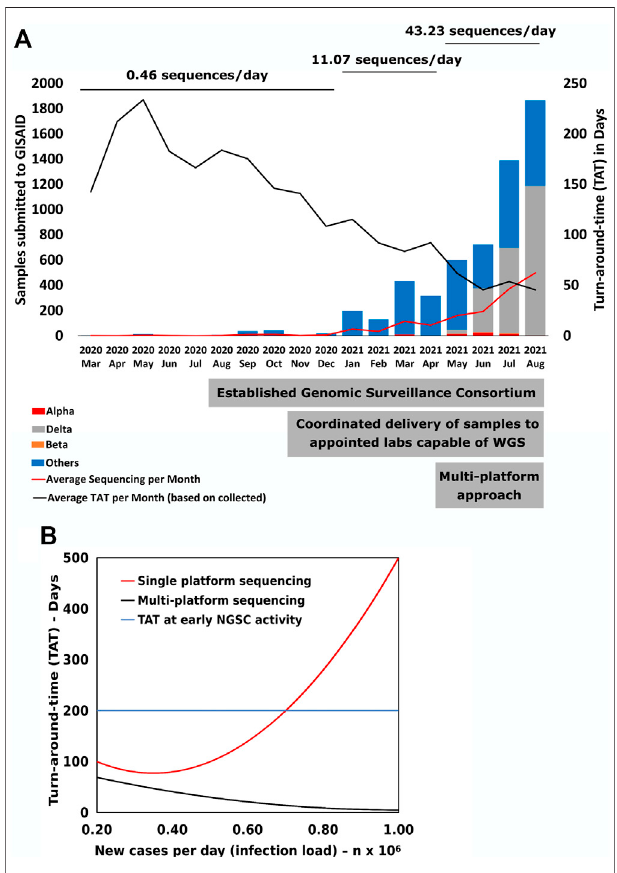
FIGURE 1 | SARS CoV-2 genomic sequencing performance. (A) MonthlychangesoftotalnumberofsubmittedSARS-CoV-2sequencestothe GISAID database. The average number of sequences per day was calculated by the total number of sequences submitted during that time period dividedbythetotalnumber ofdays.Thesigni fi cantstepstakenbythecountry are displayed at the base of fi gure. (B) Mathematical model to calculate changes in Turn-around-time (TAT) of sequencing from specimen collection date to GISAID submission date ( Y -axis) based on sequencing load associated with the number of new cases